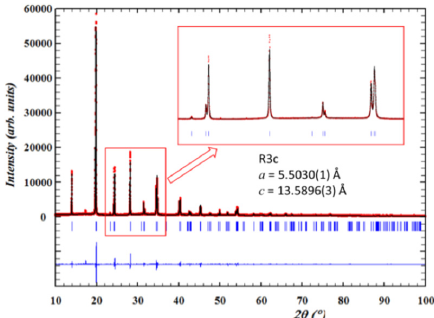
Figure 23. Synchrotron X-ray diffraction pattern and Rietveld analysis of powder flat specimen obtained by crushing the poled BNBT6 ceramic. Reliability factors: R p = 6.22, R wp = 8.61. Inset shows some relevant peaks of the rhombohedral R 3 c symmetry of the powder structure.